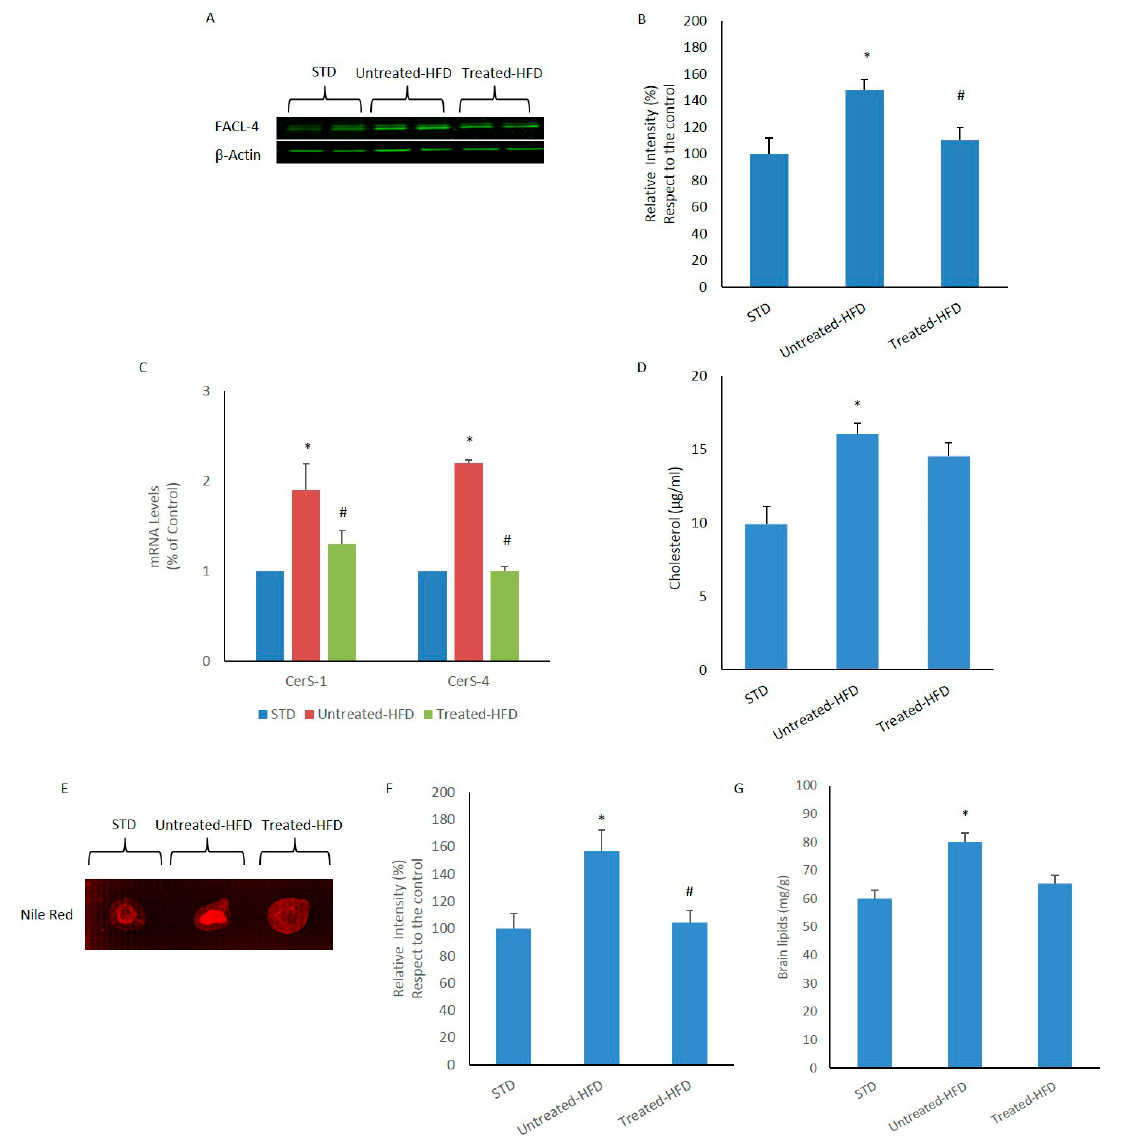
Figure 2. Lipid accumulation in the brain. ( A ) Western blot of proteins extracted from brains of STD, untreated-HFD and NDS treated-HFD mice and incubated with anti-FACL-4 and anti- β -Actin (loading control); ( B ) Quantification of immunoreactivity was performed using densitometric analysis; ( C ) CerS-1 and CerS-4 transcript levels determined by quantitative Real-Time PCR; ( D ) Cholesterol concentration in the brain tissue; ( E ) Nile Red staining of brain homogenates; ( F ) Quantification of E fluorescence intensity; ( G ) Total brain lipid levels. Data are the mean values ± SD ( n = 8/group). * p ≤ 0.05 vs. STD. # p ≤ 0.05 vs. untreated-HFD.